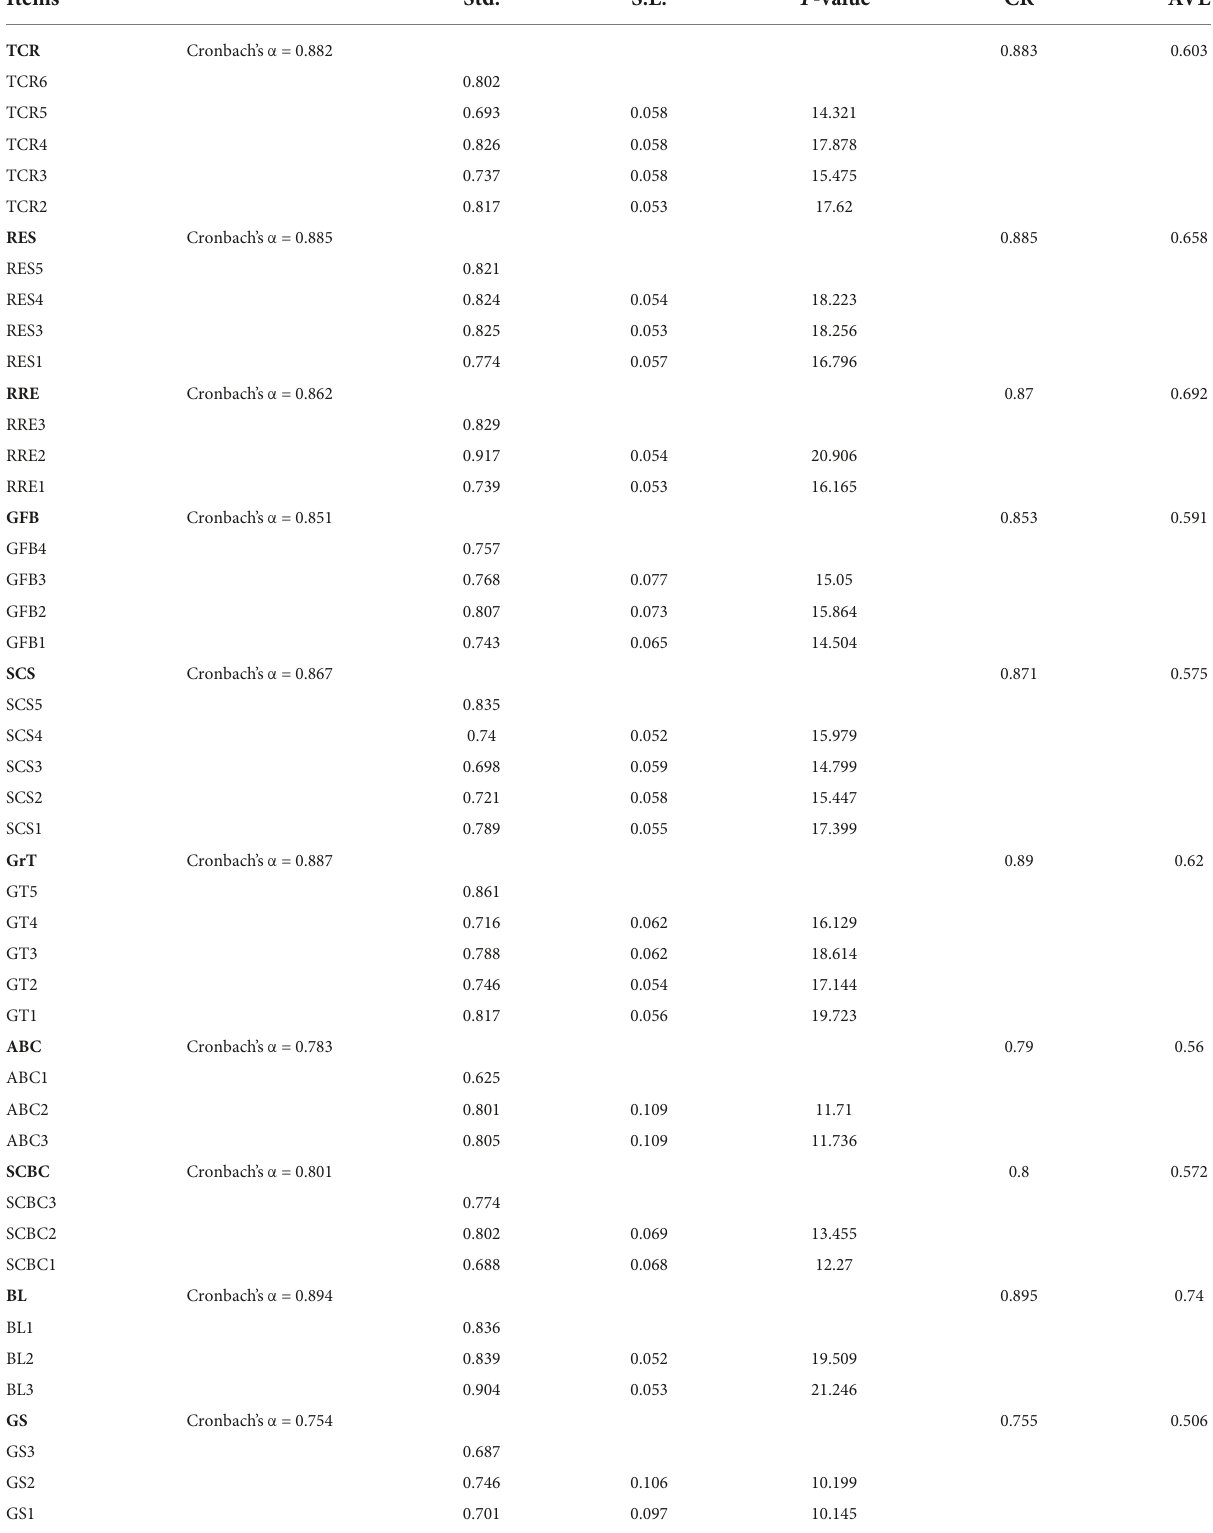
TABLE 2 The results of